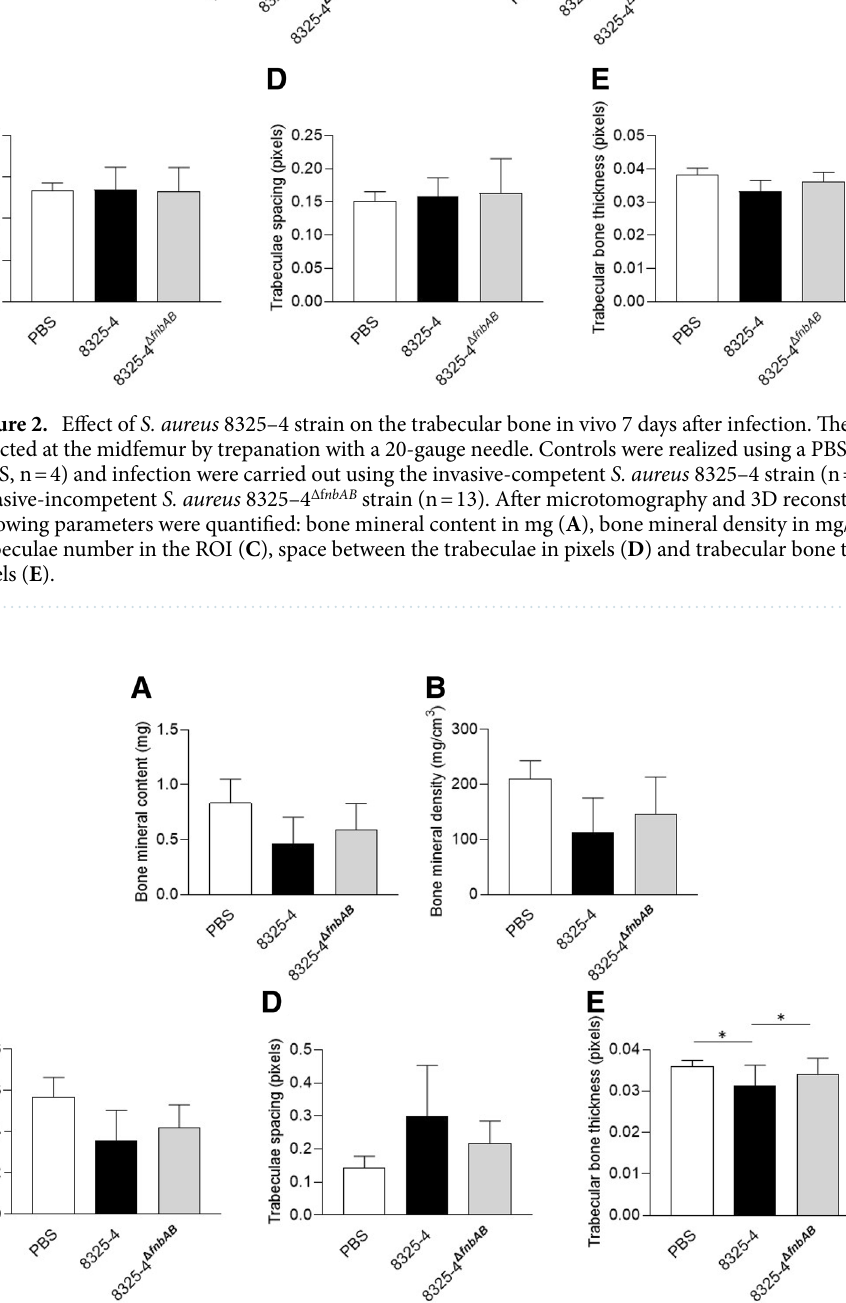
Figure 3. Effect of S. aureus 8325–4 strain on the trabecular bone in vivo 14 days after infection. A prolonged infection was performed for 14 days with the same conditions as in Fig. 6 (PBS, n = 3; 8325–4, n = 6; 8325– 4 ∆f nbAB , n = 6). After microtomography and 3D reconstruction, the following parameters were quantified: bone mineral content in mg ( A ), bone mineral density in mg/cm3 ( B ), trabeculae number in the ROI ( C ), space between the trabeculae in pixels ( D ) and trabecular bone thickness in pixels ( E ). * means P <